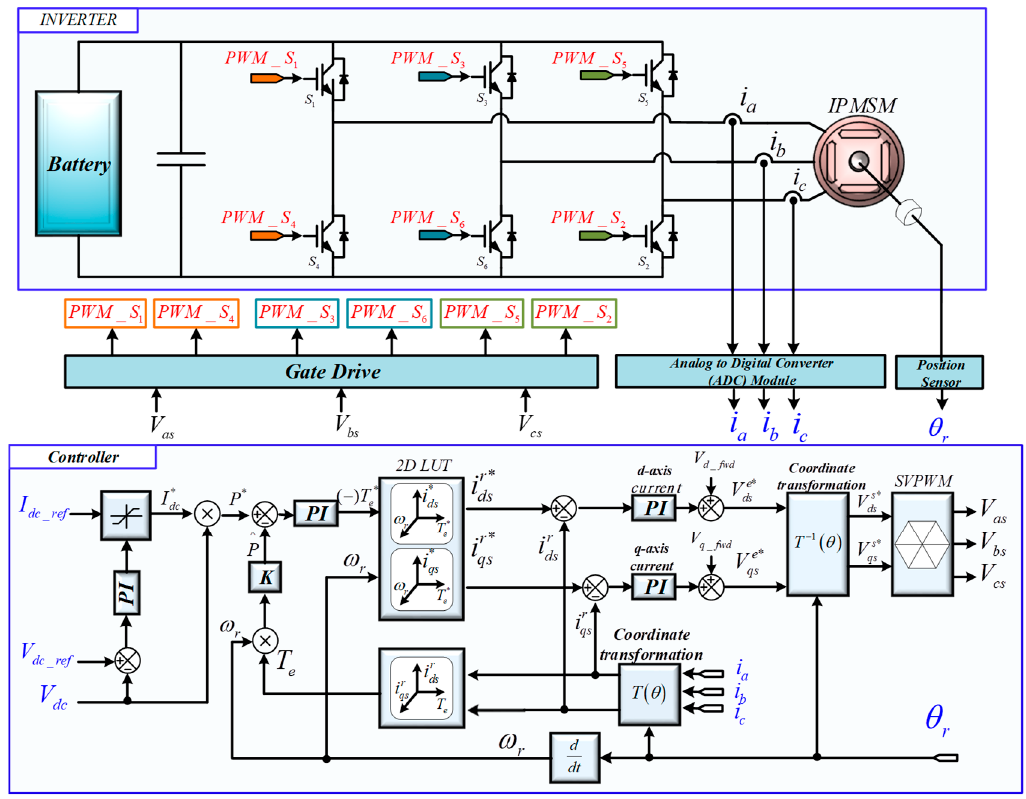
Figure 8. The proposed regenerative battery charging control method without a DC/DC converter.